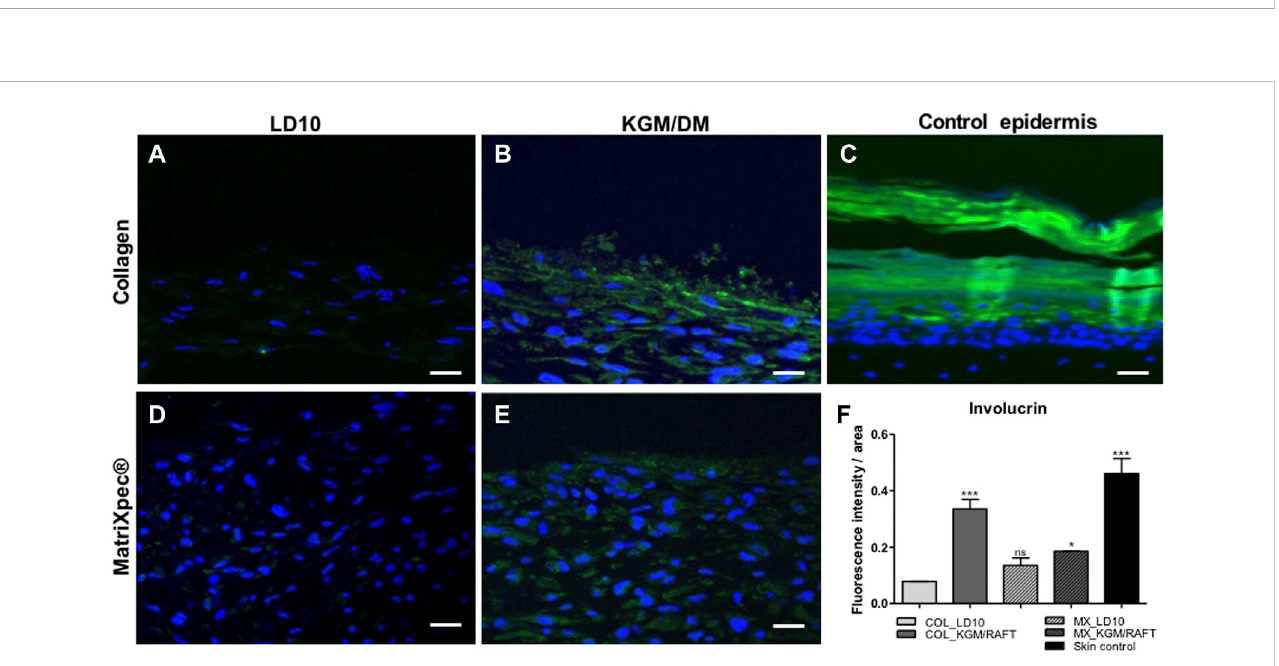
FIGURE 7 Expression of involucrin by immuno fl uorescence. (A,D) MSC cultured with LD10 or (B,E) KGM/DM onto (A,B) collagen or (D,E) MatriXpec ™ . (C) Skin formed by keratinocytes (control). Involucrin labeling is shown in green. Nuclei are stained in blue (DAPI Magni fi cation of ×200. Scale bar: 100 µm. (F) Mean fl uorescenceintensityperpixelineachgroupwascomparedtoorganotypicculturesformedbyMSCcultivatedontocollagensupportwithLD10(COL_LD10). * ( p < .05) and *** ( p <